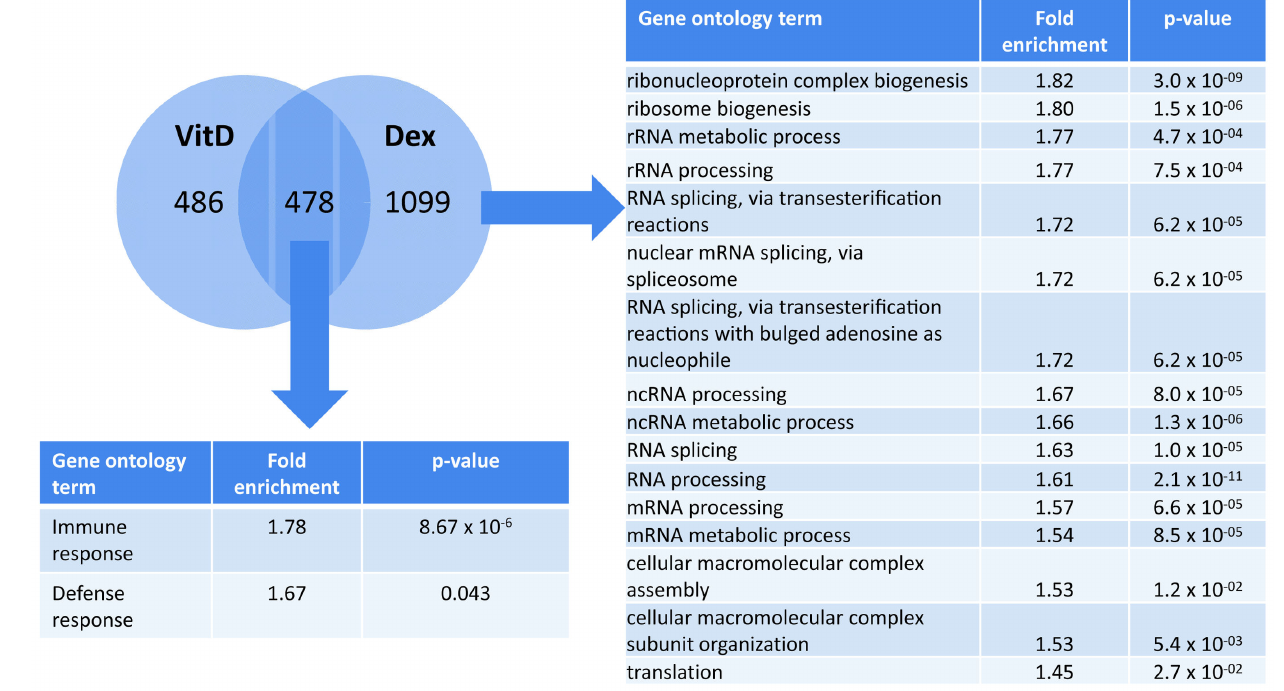
Figure 4. Intersection and significant gene set enrichment analysis of differentially expressed down-regulated genes in response to dexamethasone and vitamin D at 24 hours. Overlapping down-regulated genes were enriched for terms including “immune response” and “defense response”. Non-overlapping down-regulated genes unique to dexamethasone treatment included terms involved in RNA processing and